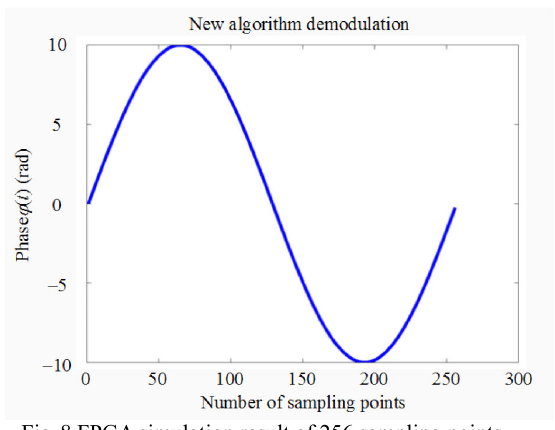
Fig. 7 FPGA simulation result of 64 sampling points.